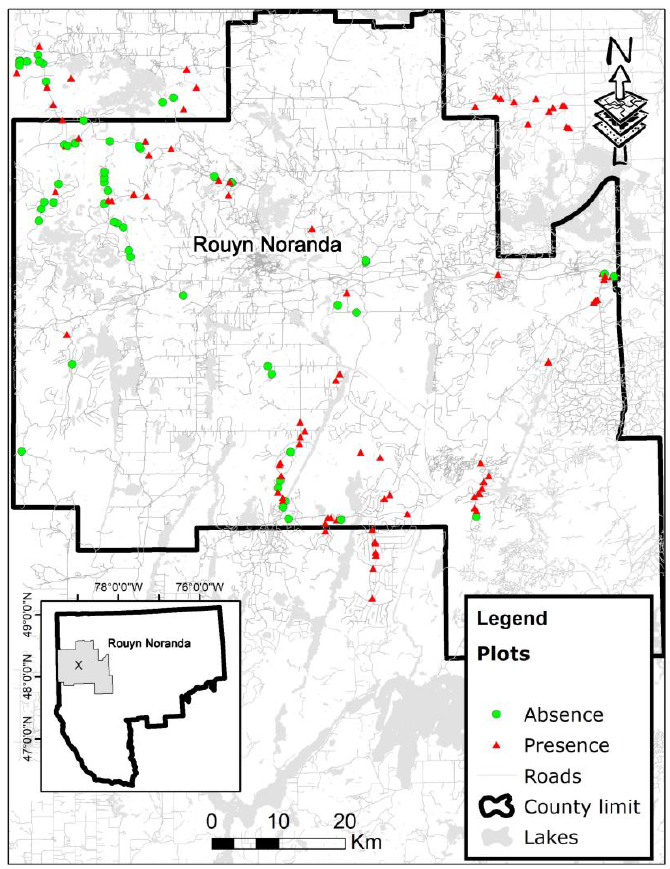
Figure 1. Locations in Abitibi, Québec, of 128 culverts that were sampled for the presence or absence of beaver dams.